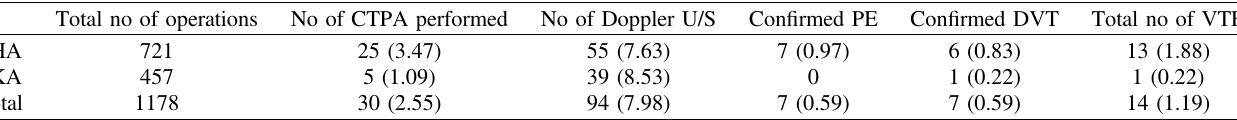
Table 1. A summary of total number of surgeries performed and how many patients received a workup with a con fi rmed diagnosis of PE or